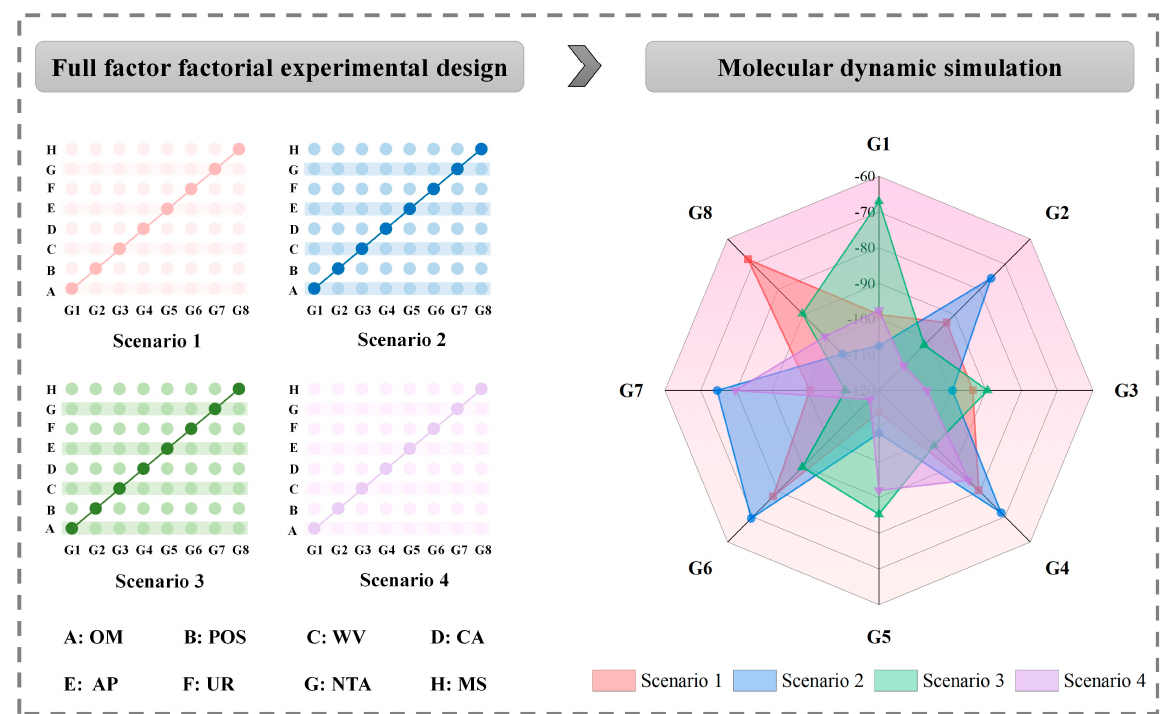
Figure 4. MD simulation results for combined biodegradation of Derivative-10 by the thermophilic group in sewage sludge composting stage under multiple scenarios.